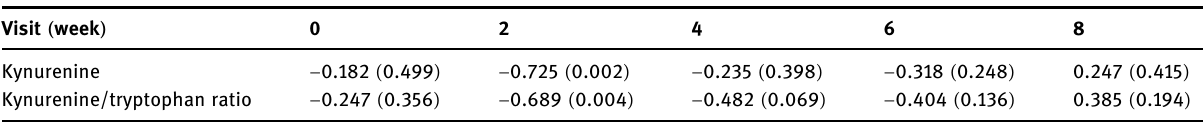
Table 4: Correlation ( Spearman ’ s rank correlation coe ffi cient ) of citrulline concentrations, and serum kynurenine concentrations and kynurenine/tryptophan ratio before and during the course of the treatment Visit ( week